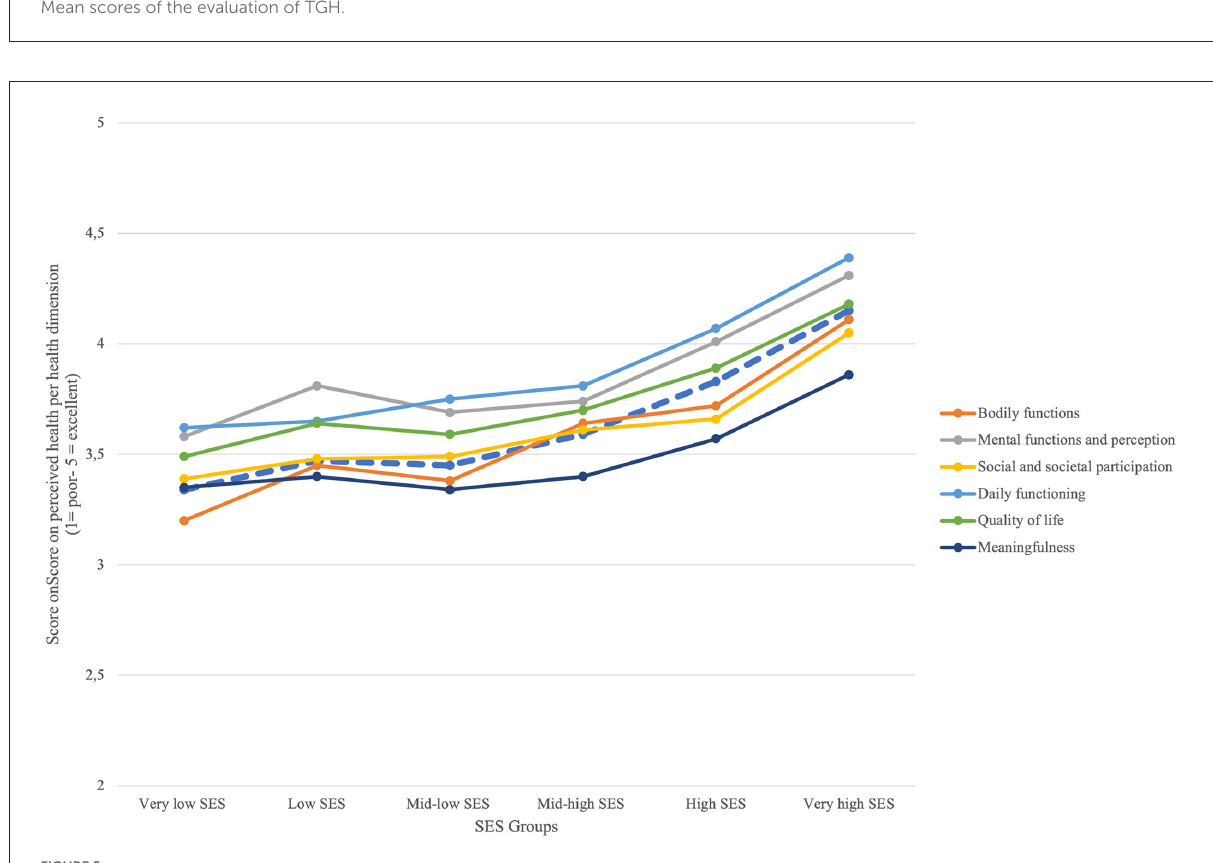
FIGURE5 Score on perceived health per health dimension.